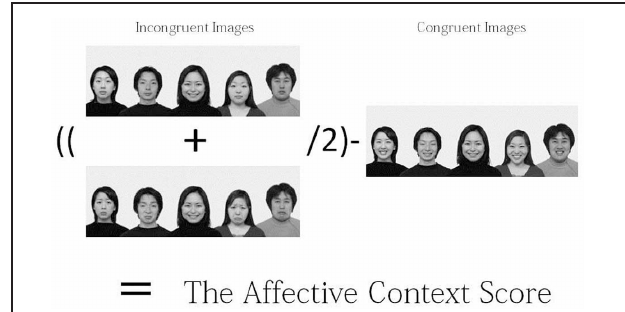
FIGURE 1 | Experimental procedure. FIGURE 2 | Formula used for computing the affective context score.